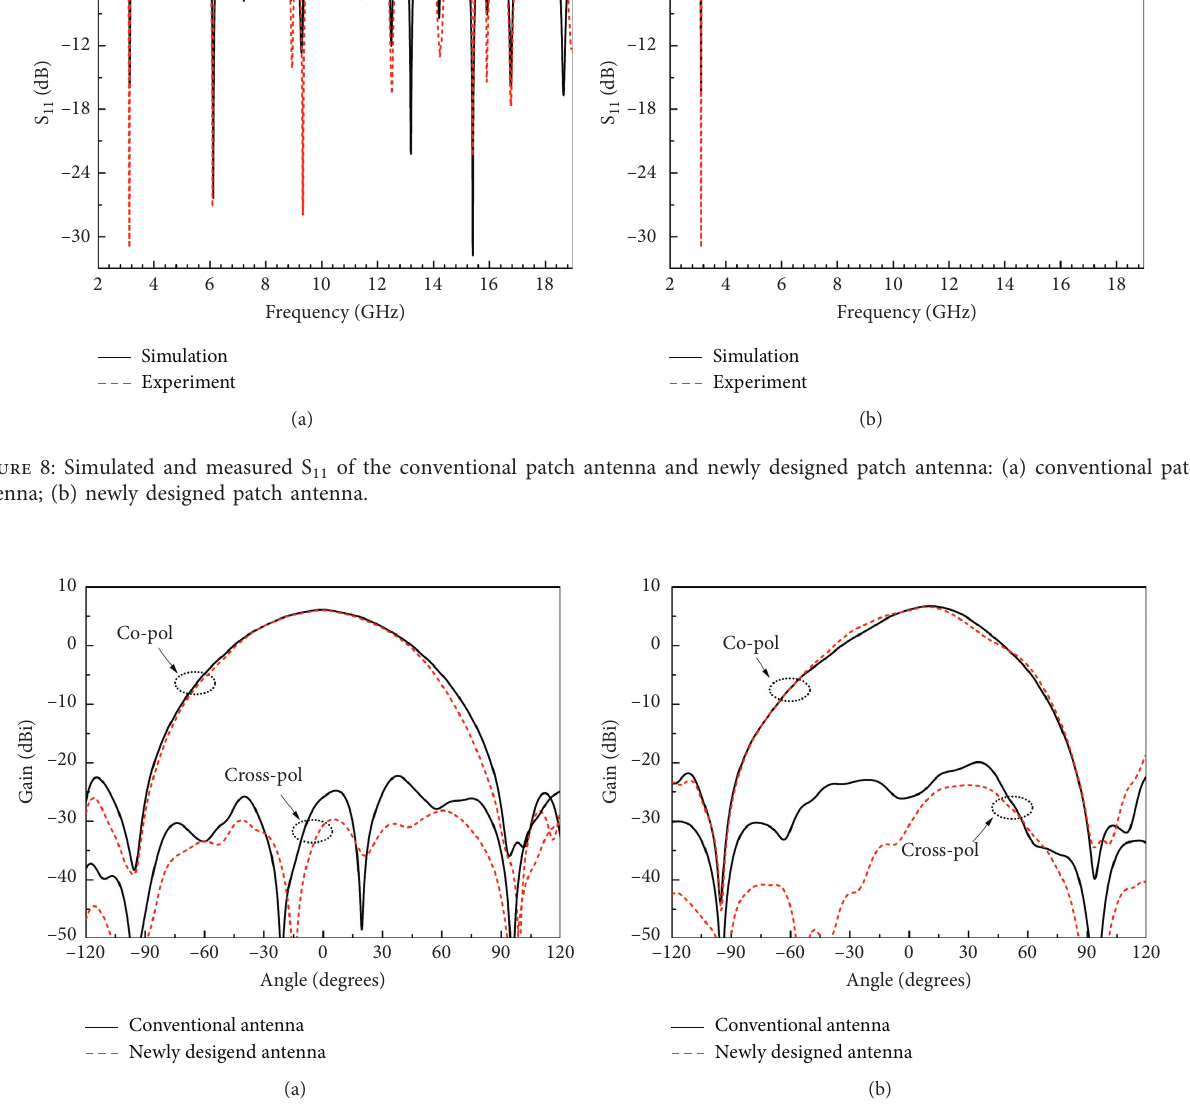
Figure 9: Measured radiation patterns of the conventional patch antenna and newly designed patch antenna at the fundamental frequency of 3.13GHz: (a) E-plane; (b)